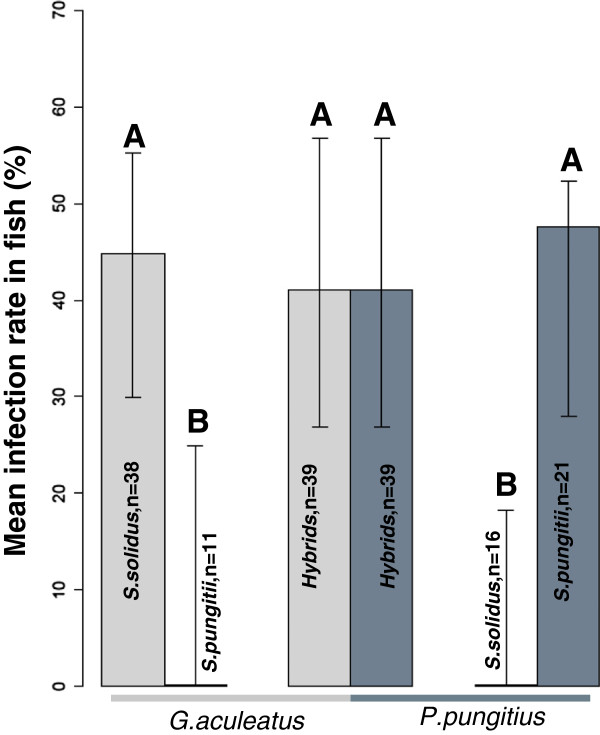
Mean infection rate in fish. Error bars show 95% CI. Groups with different letters (A, B) differ significantly from each other.